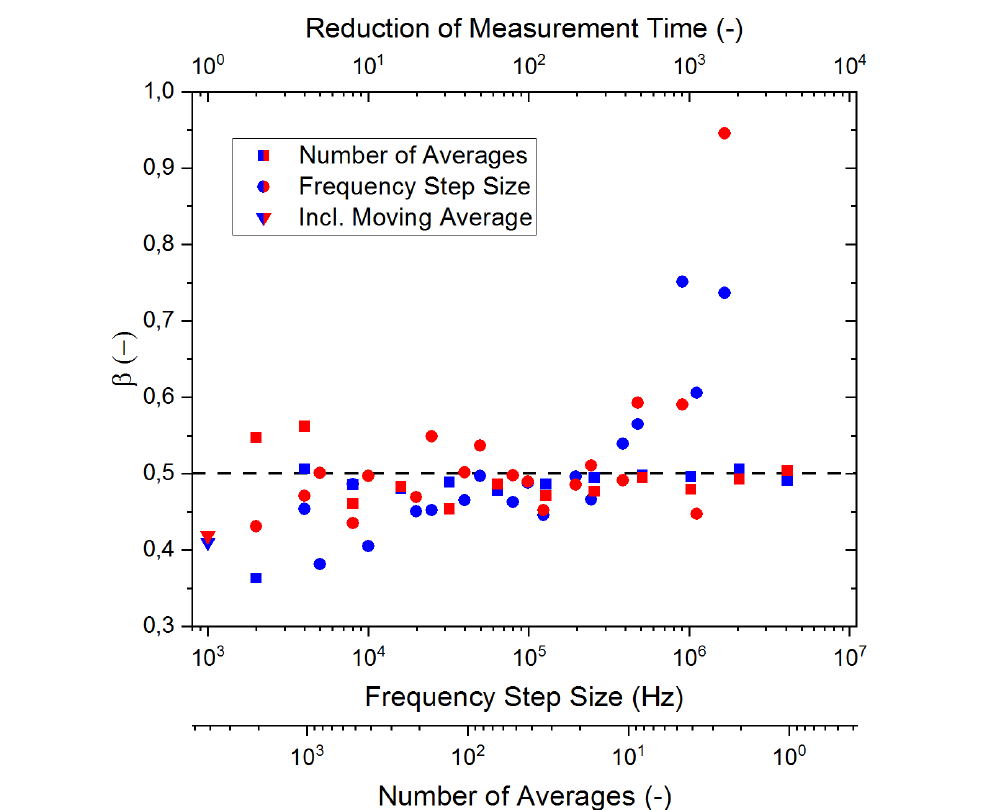
Figure 10. The exponent β which indicates the noise reduction in ∆ ( 1/ Q ) (red) and ∆ f (blue) as a function of the number of averages (square) and the frequency step size (circle) with respect to the reference measurement with 4096 averages and a frequency step size of 1 kHz. The results indicated by triangular symbols show the effect of averaging 20 consecutive time steps. The theoretically expected β is indicated by the horizontal dashed